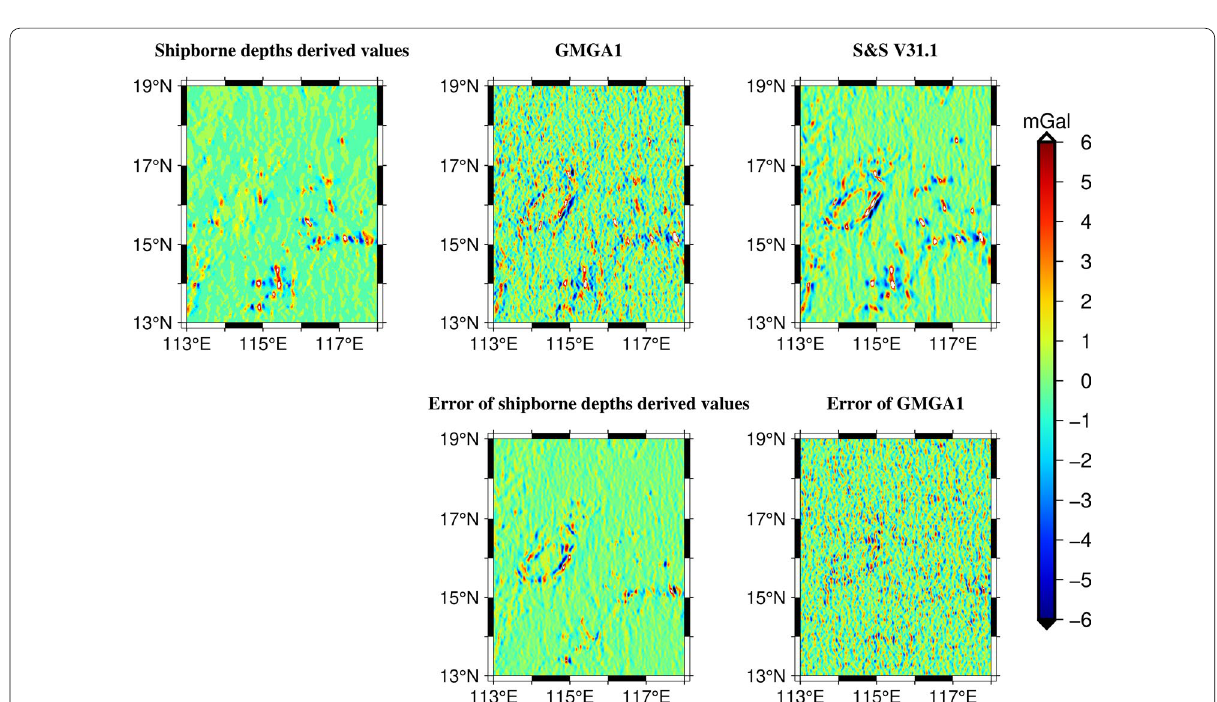
Fig. 9 Gravity anomaly and error in the wavelength range of 2–17 km